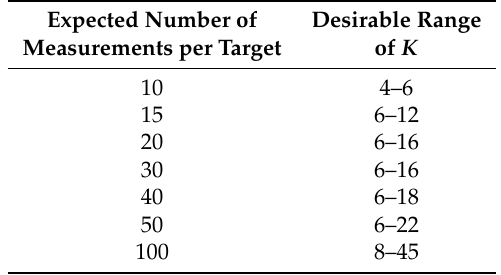
Table 2. Desirable range of the neighborhood list